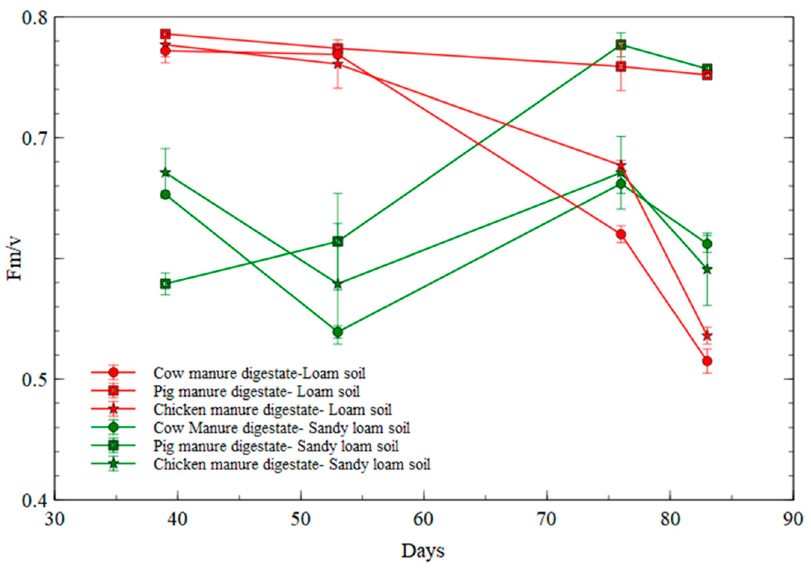
Figure 9. Florescence measurement in digestate treatments between soil types.